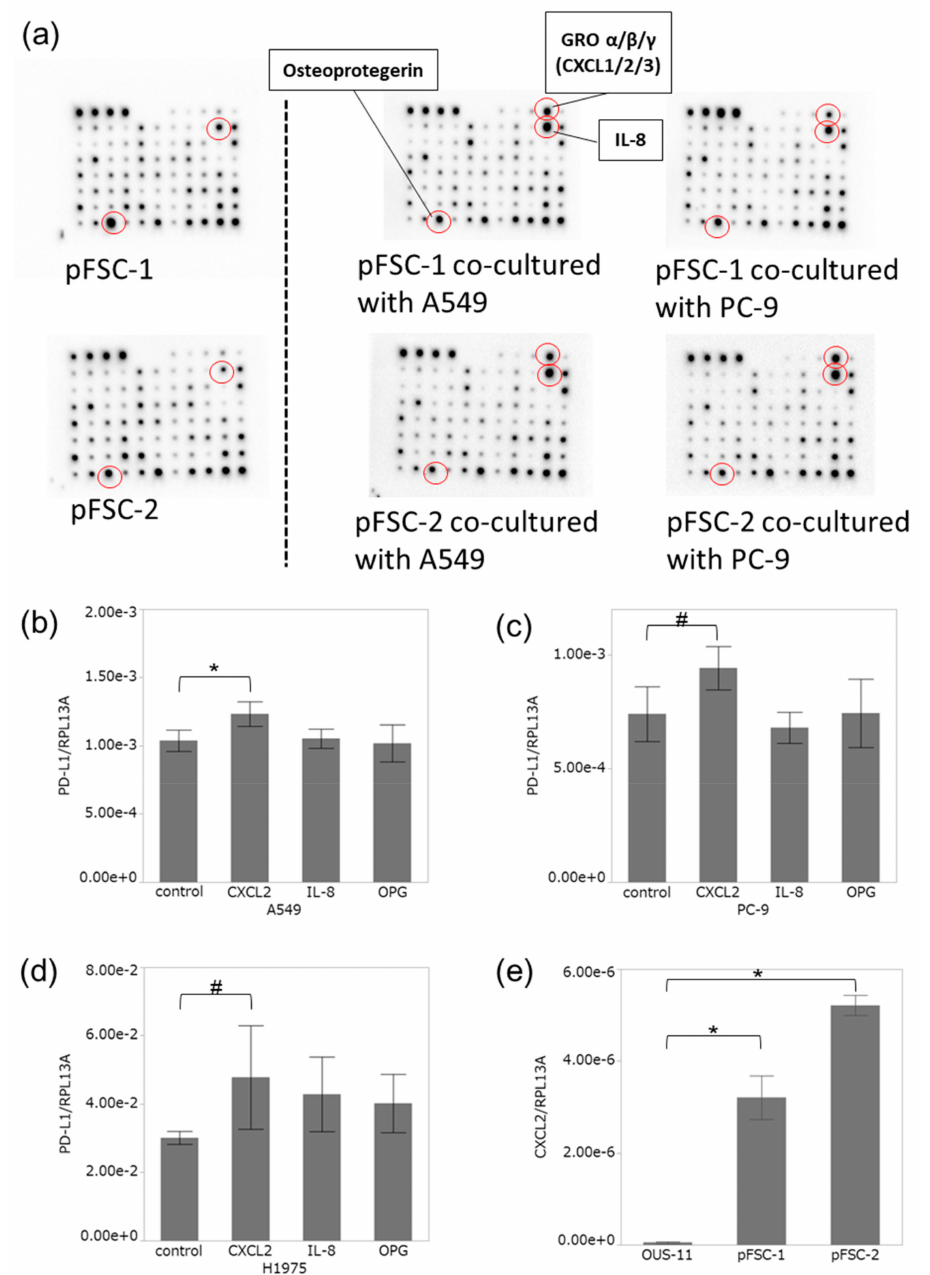
Figure 5. Cytokine antibody array image and e ff ect of cytokines on PD-L1 expression in lung cancer cell lines. ( a ) The array image showing osteoprotegerin (OPG), growth related oncogene (GRO) - α / β / γ (C-X-C motif chemokine ligand: CXCL1 / 2 / 3), and IL-8 in pFCS-1 (upper) and -2 (lower) CM with / without co-culture. E ff ect of CXCL2, IL-8, and OPG on PD-L1 mRNA level in A549 ( b ), PC-9 ( c ), and H1975 ( d ). (b) A549: CXCL2 100 ng / mL, IL-8 100 ng / mL, OPG 100 ng / mL; (c) PC-9 and (d) H1975: CXCL2 10 ng / mL, IL-8 10 ng / mL, OPG 50 ng / mL. ( e ) CXCL2 mRNA level in CAFs (pFSC-1 and pFSC-2) and normal lung fibroblasts (OUS-11). Data were presented as means ± SD from three independent experiments. * p < 0.05 vs. control. # 0.05 ≤ p < 0.1 vs.